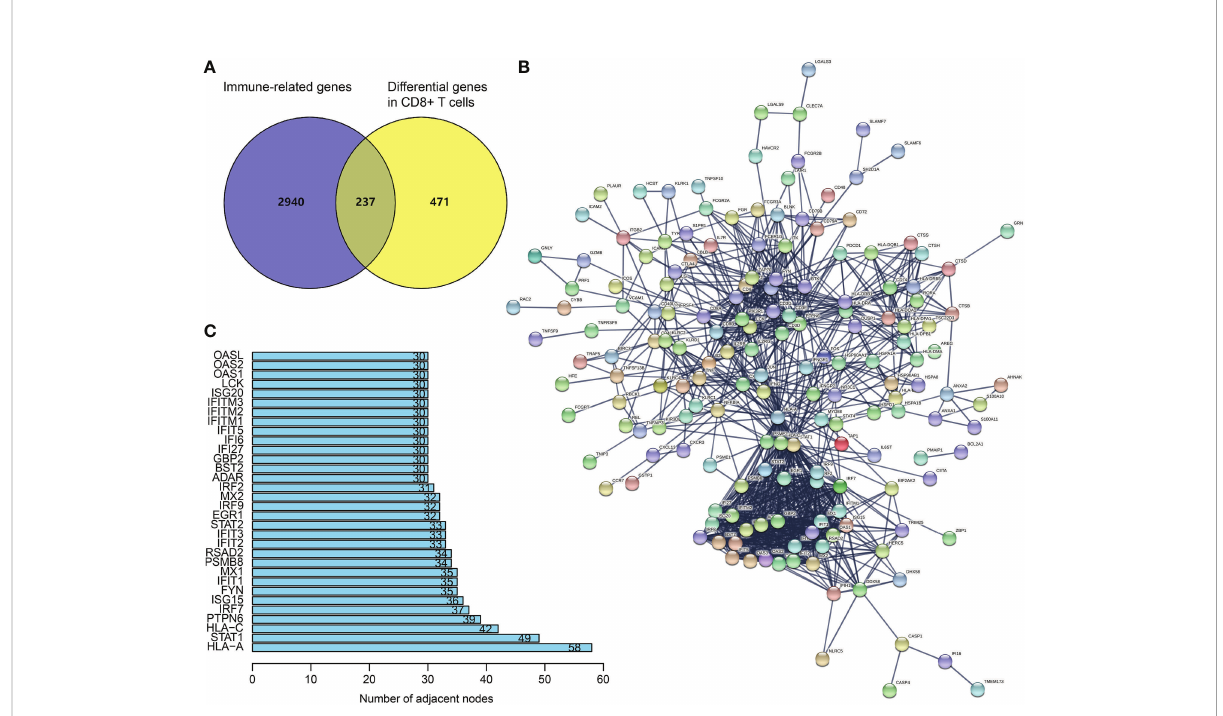
FIGURE 1 Recognition of hub CDIGs. (A) The overlapped genes of DEGs in CD8 + T cells in SKCM and IRGs. (B) The PPI network of CDIGs. (C) Hub CDIGs screened by the number of adjacent nodes ≥ 30. DEGs: differentially expressed genes, CDIGs: CD8 + T cells-associated immune